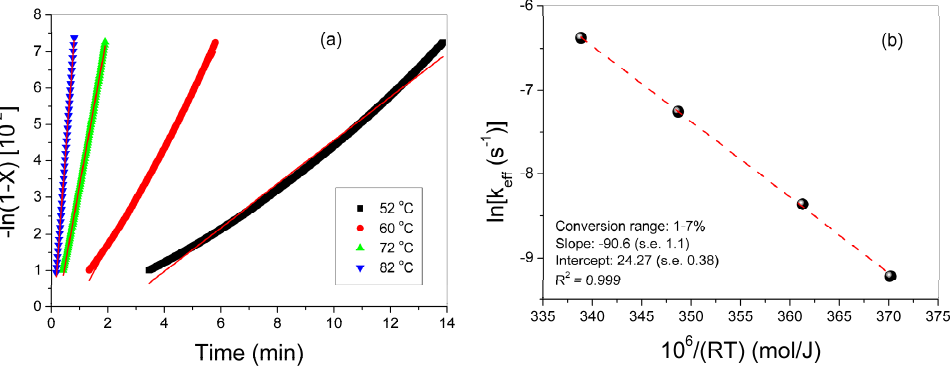
Figure 2. Estimation of the effective kinetic rate constant, k eff , using experimental data in the conversion region 1–7% at several temperatures ( a ) and the Arrhenius-type plot to calculate the overall (effective) activation energy of HEMA polymerization ( b ).